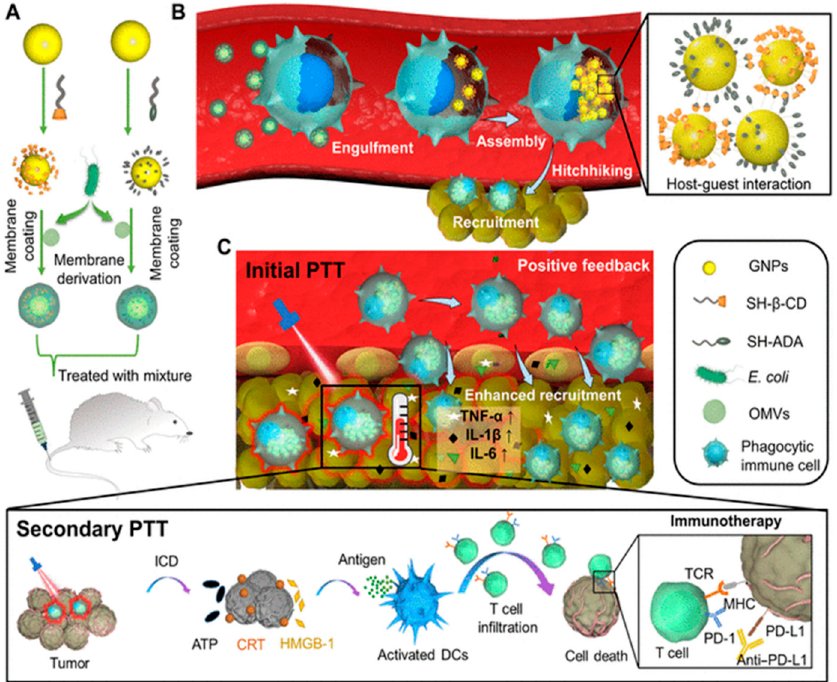
Figure 11. ( A ) E. coli BM coated on β -cyclodextrin-adamantane to prepared BM-NPs. ( B ) Selective phagocytosis of BM-NPs (Bacterial membrane coated nanoparticles) followed by degradation of coated BM and subsequent intracellular aggregation of NPs by host-guest binding of β -cyclodextrin- adamantane. ( C ) Primary photothermal therapy of tumor trigger inflammatory signals and provides a positive feedback to recruit immune cells carrying NP aggregates, secondary photothermal therapy induces significantly enhanced antitumor immune response. [reproduced with permission from Gao et al. [145], copyright 2022 AAAS] .